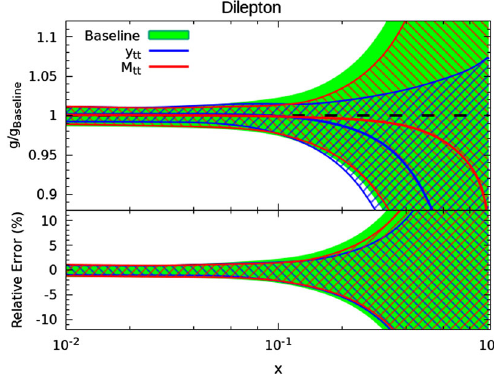
Fig. 8 Extracted gluon from a fit to the ATLAS 8 TeV lepton + jet data (all four distributions), from a fit including NNLO × EW in the cross section with (‘decorrelated’) and without (‘standard’) decorrelation of the parton shower systematic error, and from a fit with pure NLO in the cross section calculation, without decorrelation Table 5 χ 2 / N data values for fits to the ATLAS 8 TeV dilepton data